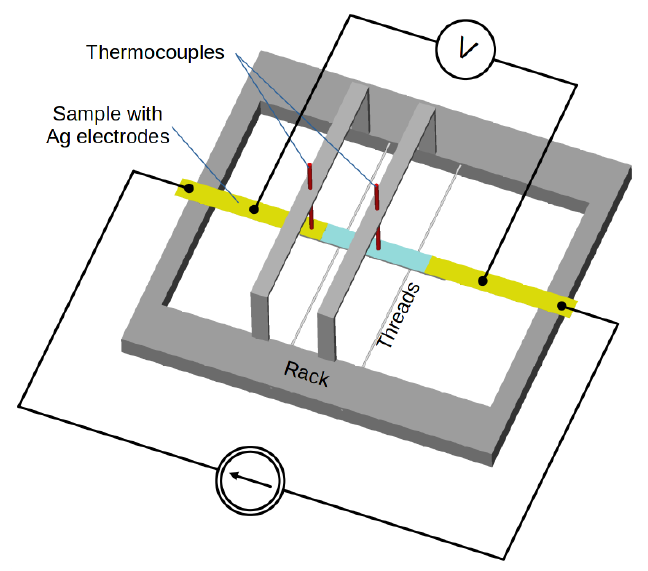
Figure 3. Schema of the rack with two thermocouples and thin threads supporting the sample.